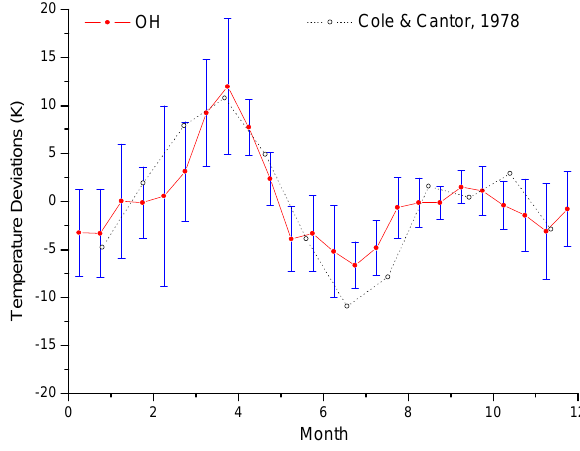
Fig. 2. The comparison plot of the mean temperature deviations for the 15-day binned OH data and the temperature deviations obtained by Cole and Cantor (1978). One could see remarkable similarities in the temperature